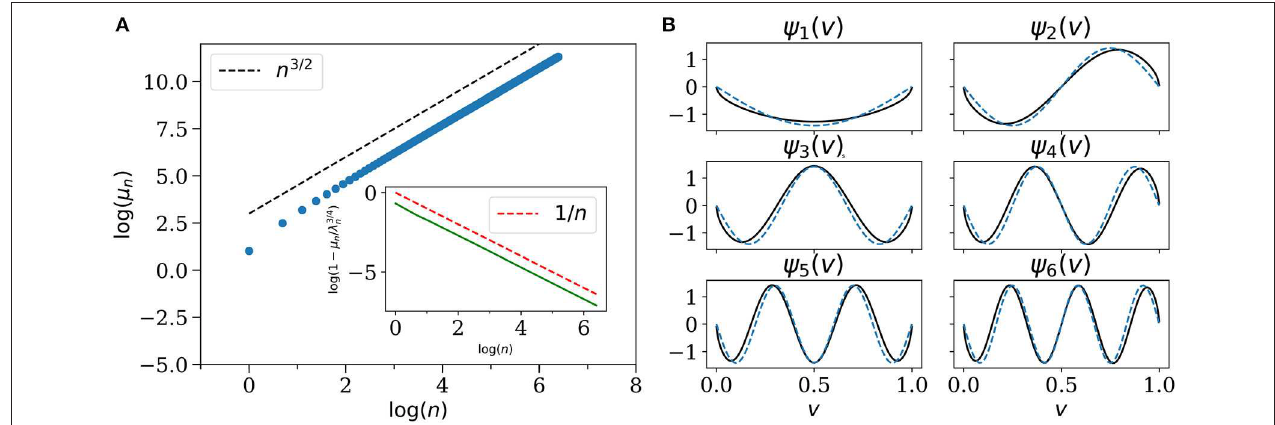
FIGURE 13 | (A) Eigenvalues of the fractional operator in Equation (90) corresponding to Dirichlet boundary conditions. For large n , the slope is seen to approach that of n 3 / 2 (black dashed line). For small n there is a systematic difference between the Dirichlet and Neumann eigenvalue and the inset plots the difference between the two. For large n the difference between the two decreases inversely with n . (B) The first six eigenvectors, ψ n ( v ) (black lines), are compared to the corresponding Dirichlet eigenfunctions of Laplacian, i.e., sin-functions (blue dashed lines). The eigenstates are different from sin-functions, especially near the boundaries, even for large n (adapted from Kundu et al. with permission from [37] Copyright SISSA Medialab Srl, IOP